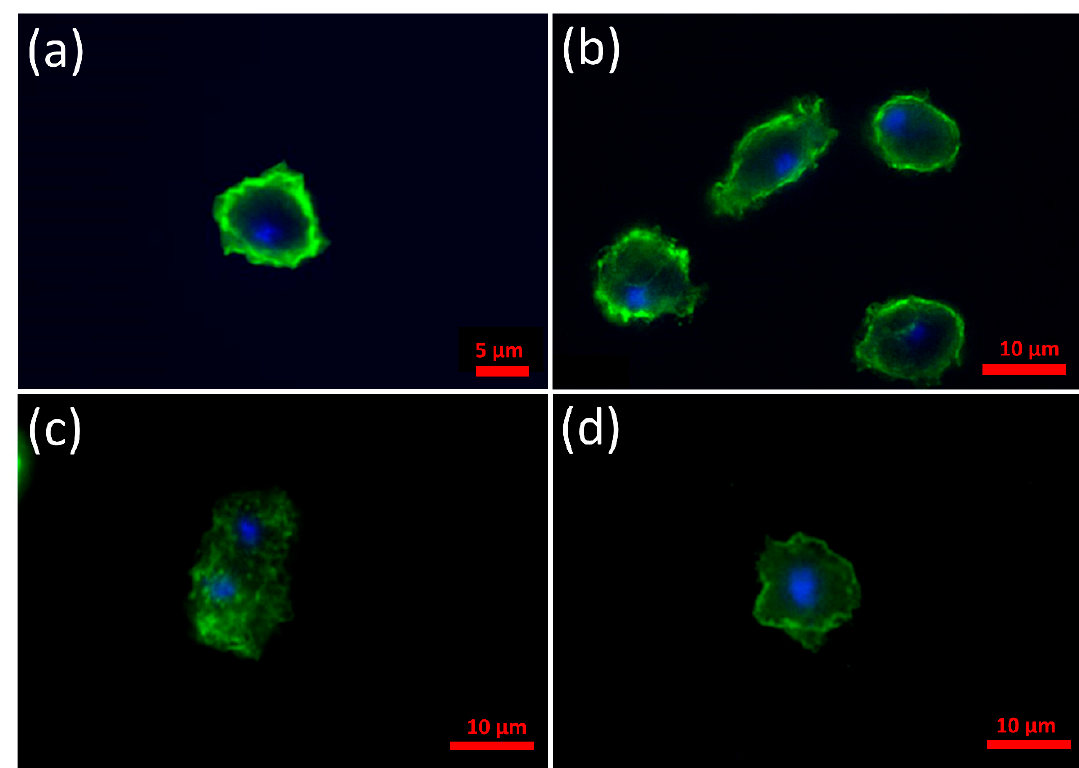
Figure 2. In Dictyostelium, α -synuclein concentrates in the cell cortex and the C-terminus is necessary and su ffi cient for this. Immunofluorescent images of strains expressing various forms of α -synuclein. The α -synuclein was detected using an anti- α -synuclein antibody and visualized with an Alexa-Fluor-488-conjugated secondary antibody. DAPI was used to detect the nucleus. ( a ) WT α -synuclein expressed in the parental strain AX2 (strain HPF891) is enriched in the cortex of the cell. ( b ) Strain HPF899 expressing α -synuclein with the point mutation A53T also exhibited enrichment at the cortex, indicating that the subcellular localization is not a ff ected by this mutation. ( c ) Strain HPF912 expressing the C terminal truncated mutant α -synuclein. The mutated protein appears granulated throughout the cytoplasm with no cortical signal observed. This indicates that the 20 residues of the C-terminal are necessary for enrichment of the protein in the cell cortex. ( d ) Cells expressing the C-terminal 20 amino acids of α -synuclein fused to GFP and visualized using an anti-GFP antibody. A strong signal is obvious at the cell cortex which suggests that these amino acids are su ffi cient for localization of α -synuclein to the cell cortex in Dictyostelium